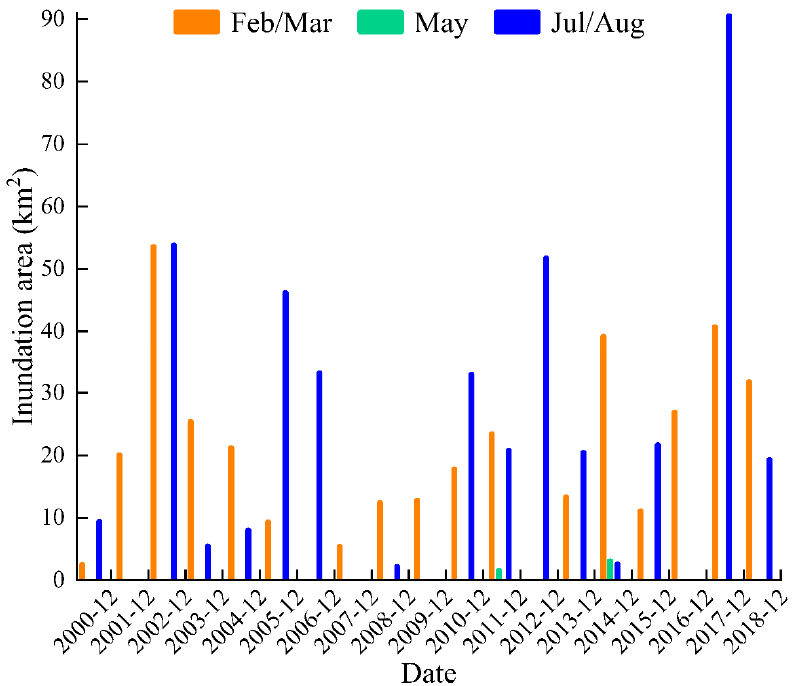
Figure 11. Observed changes of the peak values in February/March and July/August and the mini- mum in May in inundation area (2000–2018) measured within the Daliyaboyi